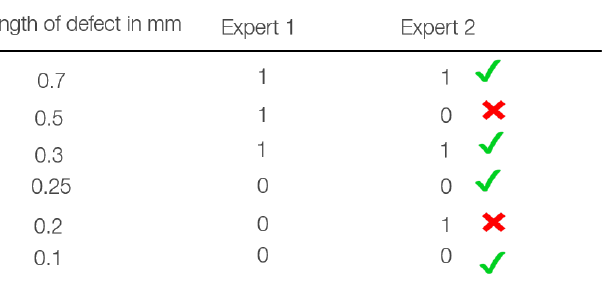
Figure 8. A non-consolidated definition of objects of interest.